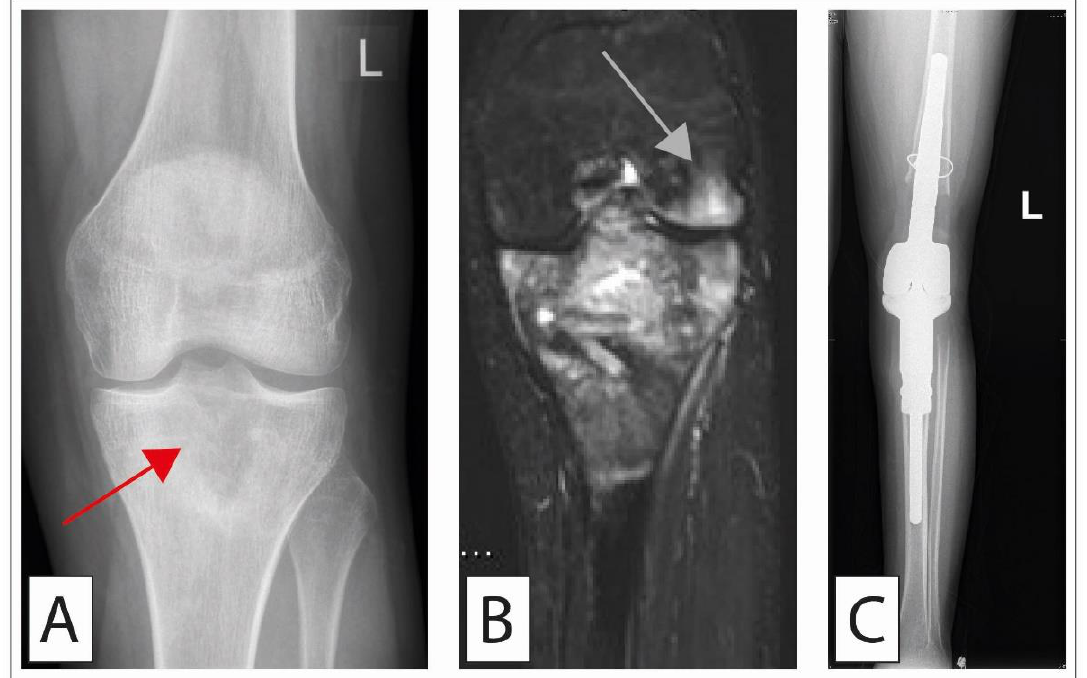
Figure 2. Osteosarcoma treated with extraarticular knee resection and implantation of a megaprosthesis. A 20-year-old patient presenting with pain in the left knee and a progressive extension deficit. ( A ) Conventional radiographs showing osteolysis in the proximal tibia (red arrow). ( B ) MR imaging (T2-tirm coronal) was performed, suggesting that the corresponding medial femoral condyle might also be affected (gray arrow). Intraarticular contamination was, therefore, assumed. Biopsy sampling was performed, showing a G3 osteosarcoma (staging: T1, Nx, M0, IIA). The patient first